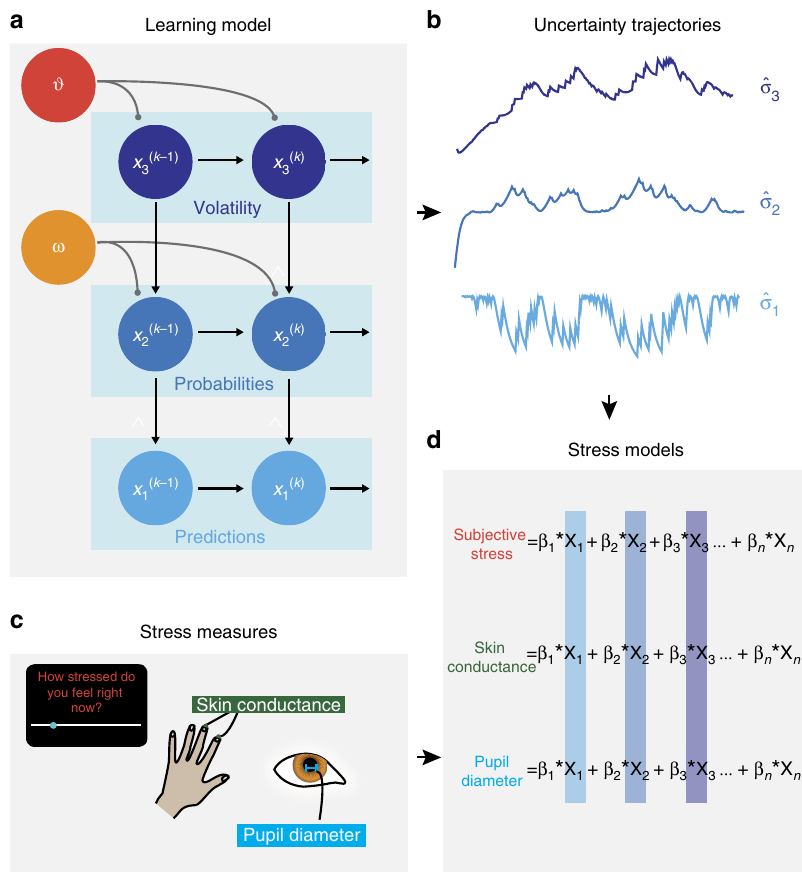
Figure 2 | Modelling of learning and stress. ( a ) Hierarchical Gaussian Filter model 21 . Beliefs are represented in probability distributions organized in a hierarchy, with the speed of updating at each level influenced by the estimate at the level above. This allows learning to occur more quickly in volatile environments. Each level is Gaussian, characterized by a mean ( m ) and a variance ( s ), which corresponds to uncertainty. These representations unfold over time, with the model furnishing an estimate at each level, for each trial. We take these dynamic representations of uncertainty from this model ( b ) and use them to predict stress responses ( c ) using linear modelling ( d ). The resultant regression coefficients ( b 1 (cid:2) n ) quantify the influence of each form of uncertainty on that stress measure. Note that X 1 (cid:2) n are the regressors in the linear model, which include but are not limited to uncertainty trajectories; we also include terms such as number of shocks, and nuisance variables such as gaze